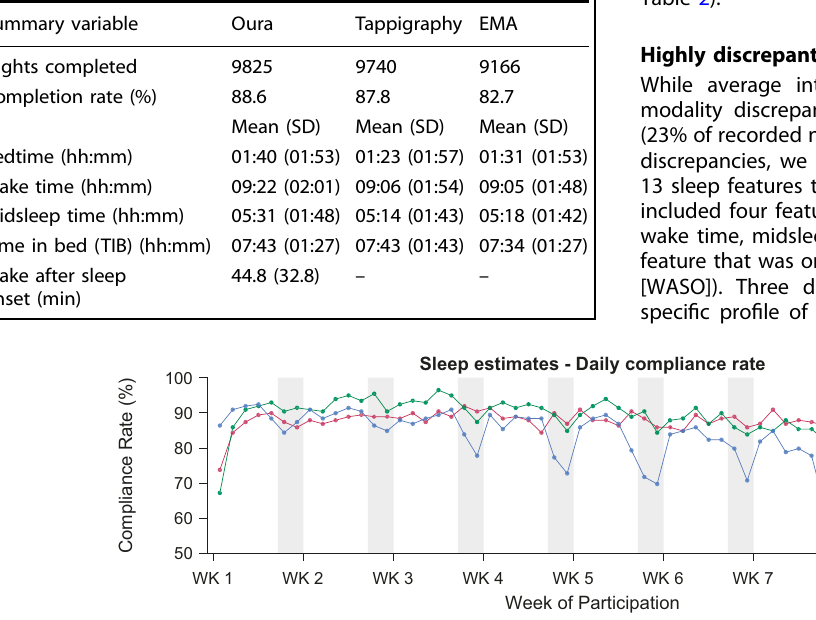
Fig. 1 Data completion over time. Daily compliance rate for tappigraphy (Tap; pink curve), Oura (green curve), and self-reported EMA (blue curve). Weekends are delineated as grey-shaded regions. Average daily compliance rates for each modality during the fi nal week of subjects ’ participation are also